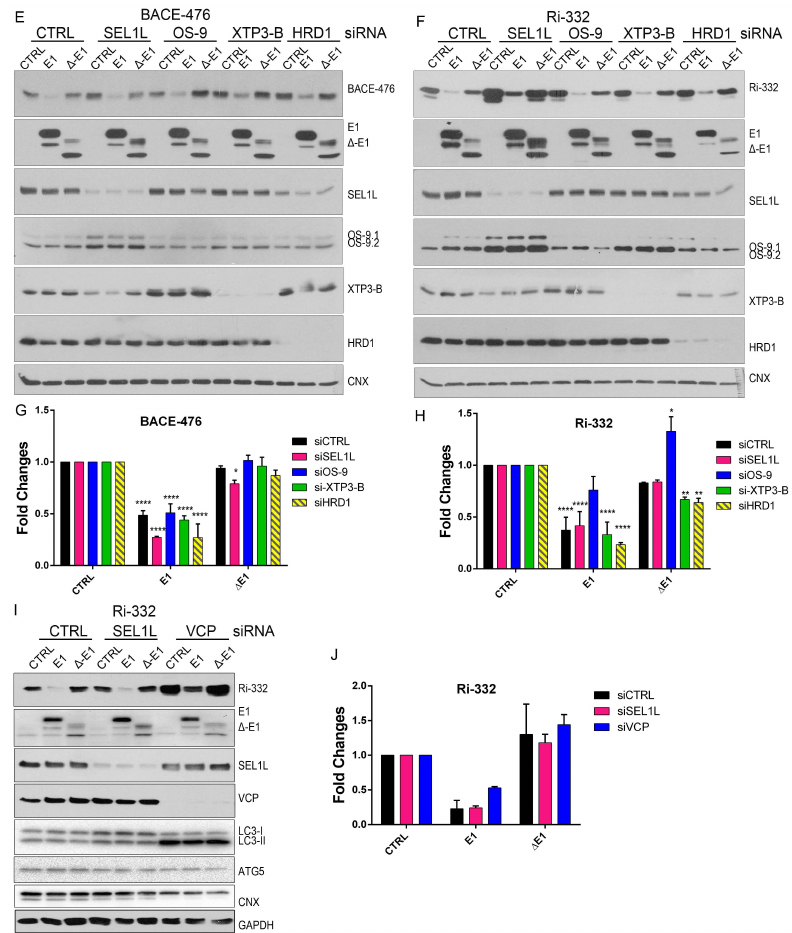
Figure 4. EDEM1 accelerates the degradation of misfolded polypeptides even when ERAD is not functional. ( A ) HEK293T cells were transfected with siRNA targeting a non-specific sequence (CTRL), SEL1L, OS-9, XTP3-B, and HDR1 for 72 h; during the last 24 h, another transfection was made to overexpress an empty vector (CTRL), EDEM1 (E1), and ∆ -EDEM1 ( ∆ -E1), along with α -1AT. Cells were harvested, lysed in Triton-X 100-containing bu ff er, and an equal amount of protein from each sample was separated by SDS-PAGE in reducing conditions. Protein expression was estimated by Western blotting using antibodies against α -1AT, EDEM1, SEL1L, OS-9, XTP3-B, HRD1, and CNX as an internal control. ( B ): The same experiment was performed for NHK and its expression, and the above-mentioned proteins were detected by Western blotting. ( C , D ) Band densitometry plot of α -1AT and NHK presented in ( A ) and ( B ), respectively (mean n = 3 ± SEM), and two-way ANOVA comparison with Bonferroni correction was applied for statistical analysis (* p < 0.05, ** p < 0.01, *** p < 0.001, and **** p < 0.001). For simplicity only statistically significant samples are indicated. ( E,F ) During the last 24 h of siRNA transfection, BACE-476 and Ri-332 were co-expressed with an empty vector (CTRL), EDEM1 (E1), and ∆ -EDEM1 ( ∆ -E1) in HEK293T, in a similar experiment to that in ( A ). The protein expression was estimated by Western blotting using antibodies against BACE1 ( E ) and Ribophorin I ( F ) alongside EDEM1, SEL1L, OS-9, XTP3-B, HRD1, and CNX as an internal control. ( G,H ) Band densitometry plot of BACE-476 and Ri-332 presented in ( E ) and ( F ), respectively (mean n = 3 ± SEM), and two-way ANOVA comparison with Bonferroni correction was applied for statistical analysis (* p < 0.05, ** p < 0.01, *** p < 0.001, and **** p < 0.001). For simplicity of representation, only statistically significant samples are indicated. ( I ): HEK293T cells were transfected with siRNA that targeted a non-specific sequence (CTRL), SEL1L, or p97 / VCP for 72 h; during the last 24 h, the cells were transfected to co-express Ri-332 alongside an empty vector (CTRL), EDEM1(E1), and ∆ -EDEM1 ( ∆ -E1). Samples were processed as in ( A ), and the membranes were probed with antibodies for Ribophorin-I, EDEM1, SEL1L, VCP, LC3, ATG5, CNX, and GAPDH. ( J ): Band densitometry plot of Ri-332 is presented in ( I ) (mean n = 2 ±